Question: Looking at the figure, what chart type is it?
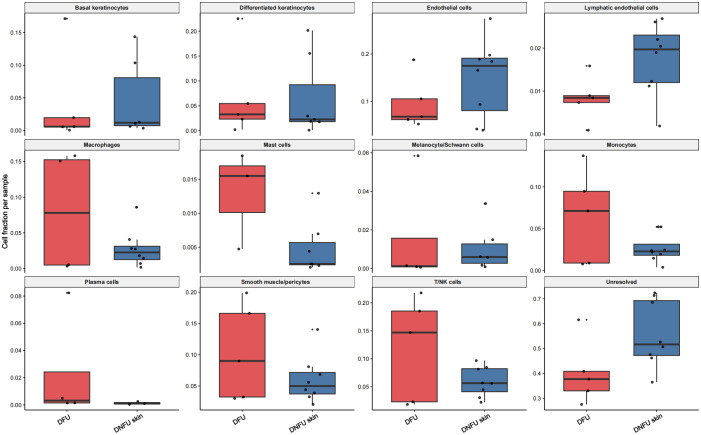
Answer: box